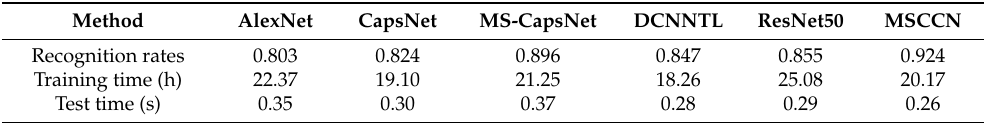
Figure 8. The loss versus iterations of three models. Table 2. Average recognition rates of five models.